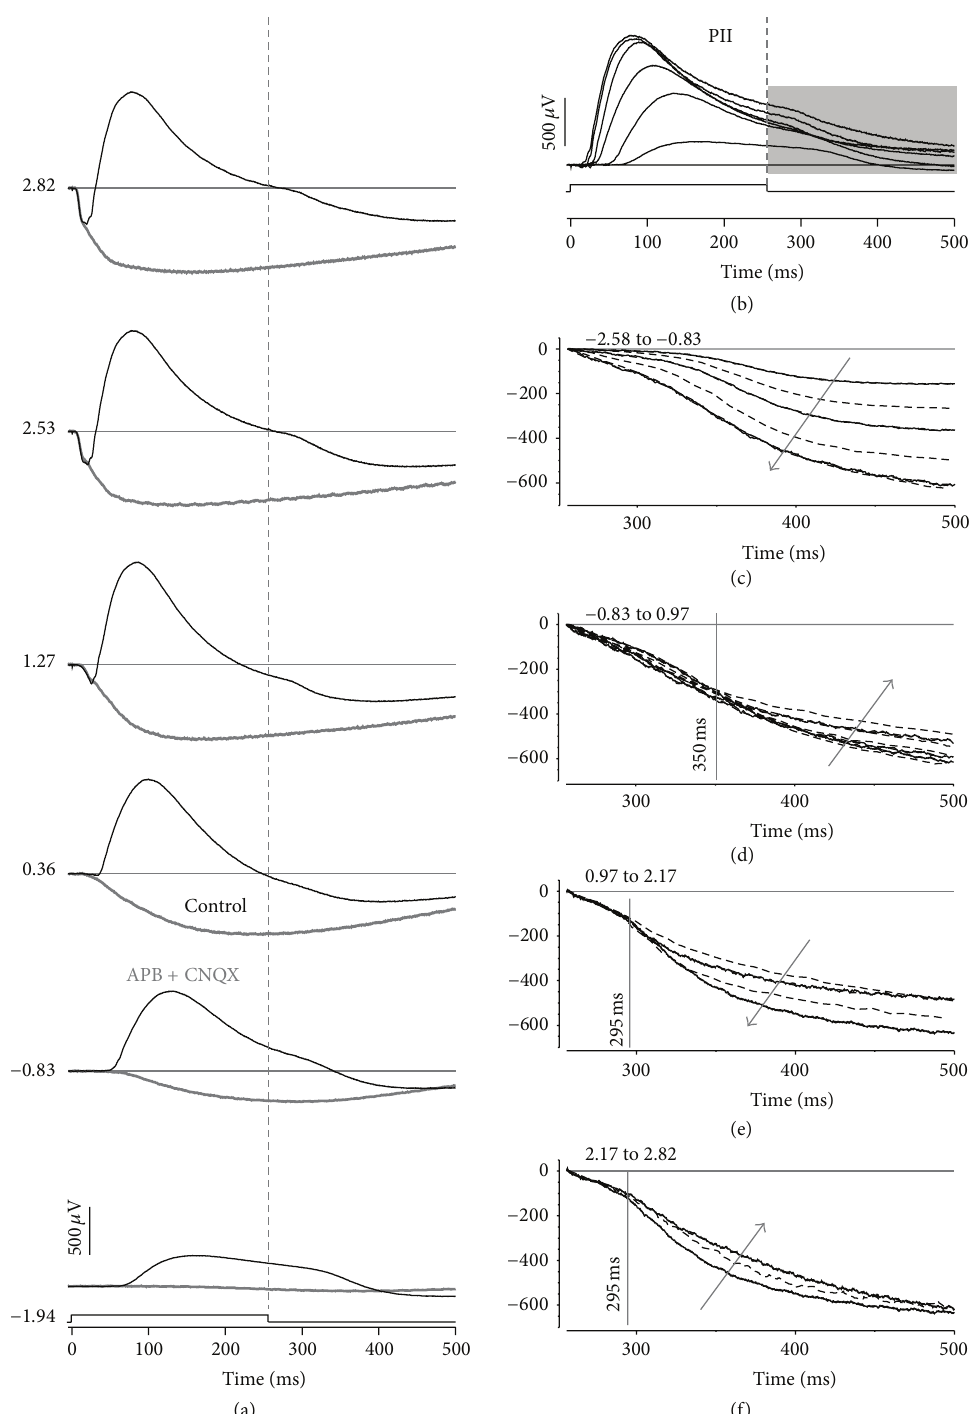
Figure 1: Rat electroretinogram in response to a light step. (a) Average waveforms for animals treated with APB/CNQX (thin grey) compared to untreated control eyes (black). The numbers along the right hand side represent the luminance in logcd ⋅ m −2 . (b) The responses from photoreceptoral, photoreceptoral-driven glial, and RPE responses are removed by subtracting APB- and CNQX-treated waveforms.